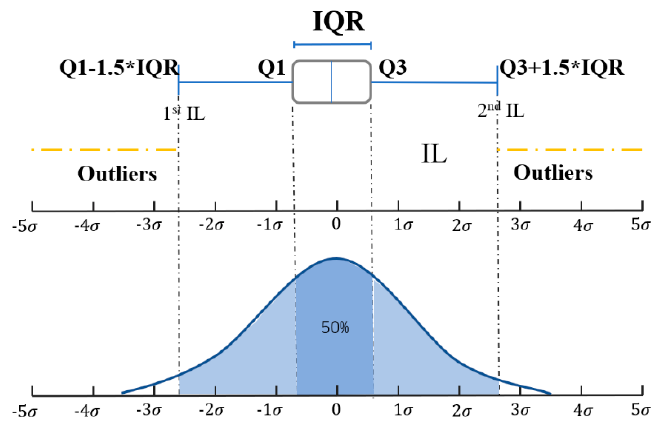
Figure 6. Removal of outliers using IQR method.